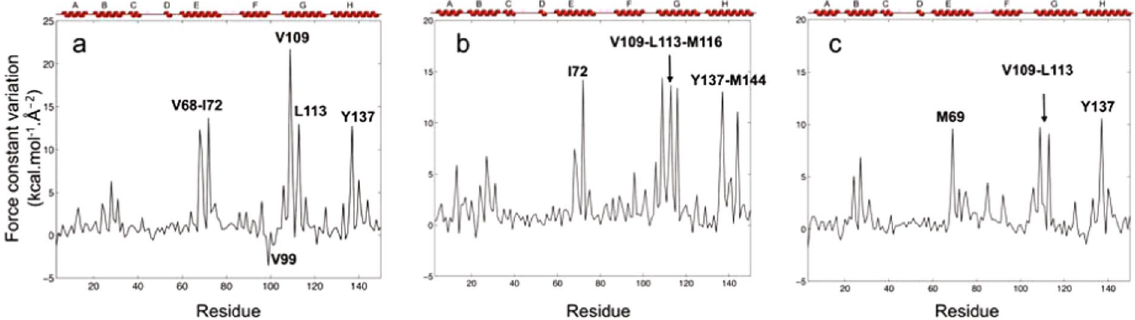
Figure 5. Force constant variation in kcal.mol − 1 .Å 2 (1 kcal.mol − 1 .Å − 2 = 0.7 N.m − 1 ) along the protein sequence. (a) when changing from ambient pressure to 310 MPa in the WT, (b) when changing from ambient pressure to 240 MPa in the V101F mutant, (c) when changing from ambient pressure to 310 MPa in the F106W